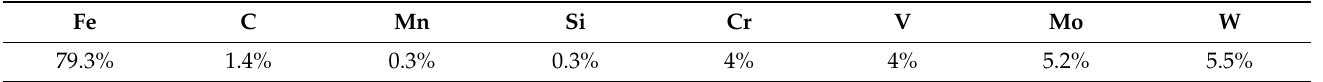
Table 2. Chemical composition of Zapp Z-M4 PM in wt%